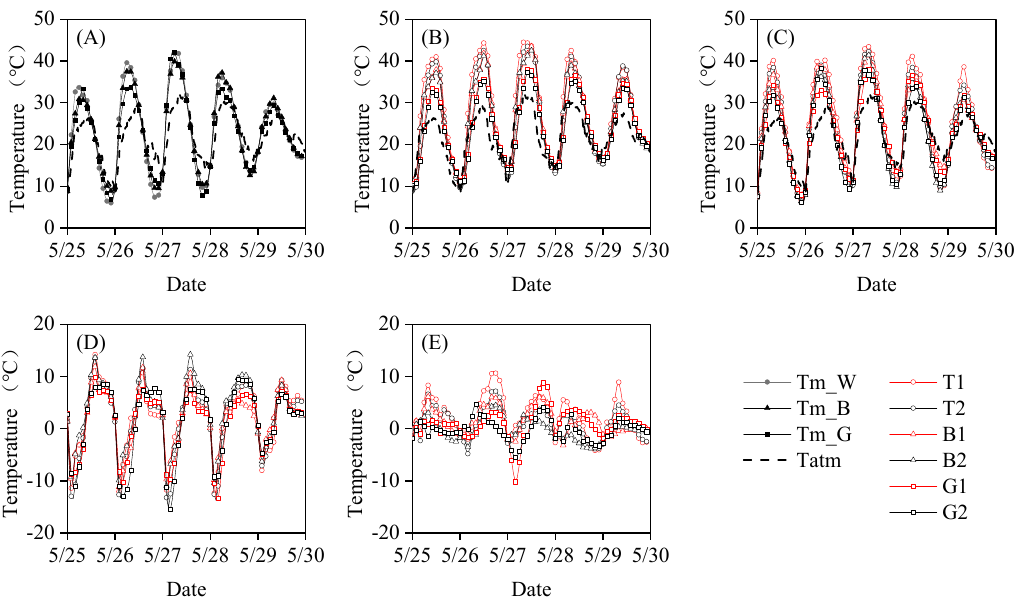
Figure 7. Comparisons of ( A ) plastic film temperature ( T m ); ( B ) temperature below the soil surface ( T l ); ( C ) soil surface temperature ( T s ); ( D ) the difference between T l and T s ( T l − T s ); ( E ) the difference between T s and T m ( T s − T m ) for the six treatments.